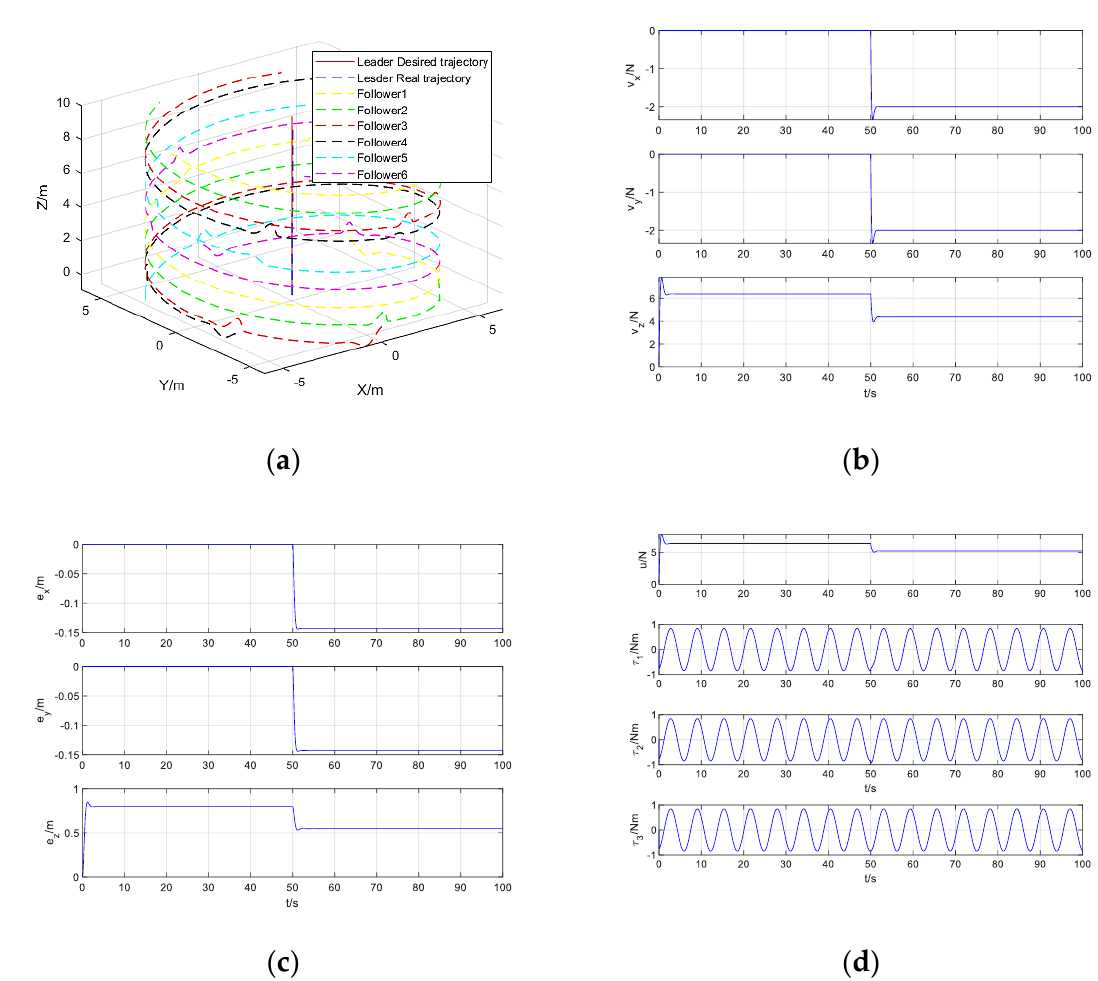
Figure 9. Simulation results of quadrotor formation cooperative trajectory tracking when use PD control: ( a ) Formation cooperative trajectory tracking; ( b ) Virtual control input; ( c ) Trajectory tracking error; ( d ) Control input.